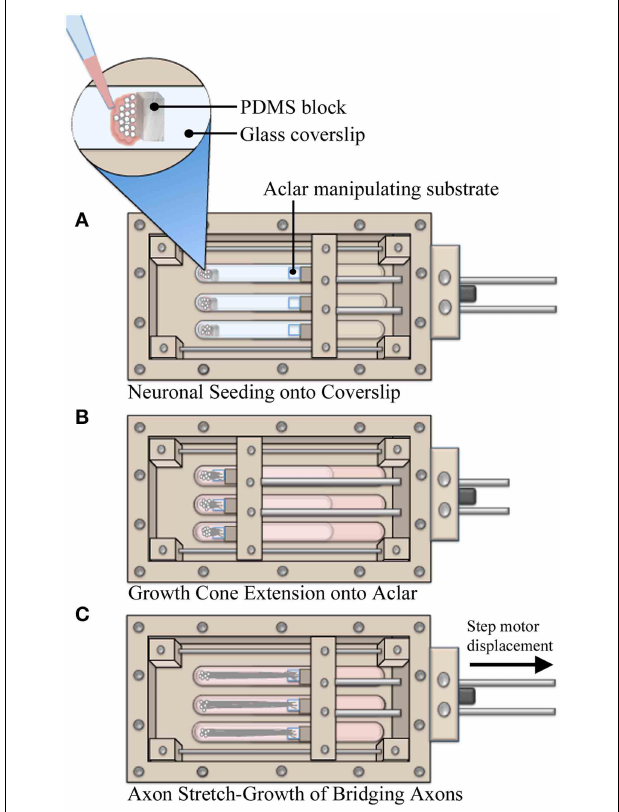
FIGURE 1 | Axon stretch-growth methodology. (A) Neurons were seeded against PDMS barriers to create culture homogeneity such that all cell bodies were positioned on coverglass. Precise positioning of PDMS within multiple culture lanes also set consistent spacing between cells and Aclar substrates, resulting in consistent pre-stretch axon lengths. (B) Aclar substrates were positioned within 250–500 μ m of the seeded cells to allow for growth cone extension and adhesion while the system was held statically over 4–5 days. (C) Stretch was applied by manipulating Aclar substrates away from the seeding area, applying strain to bridging axons.